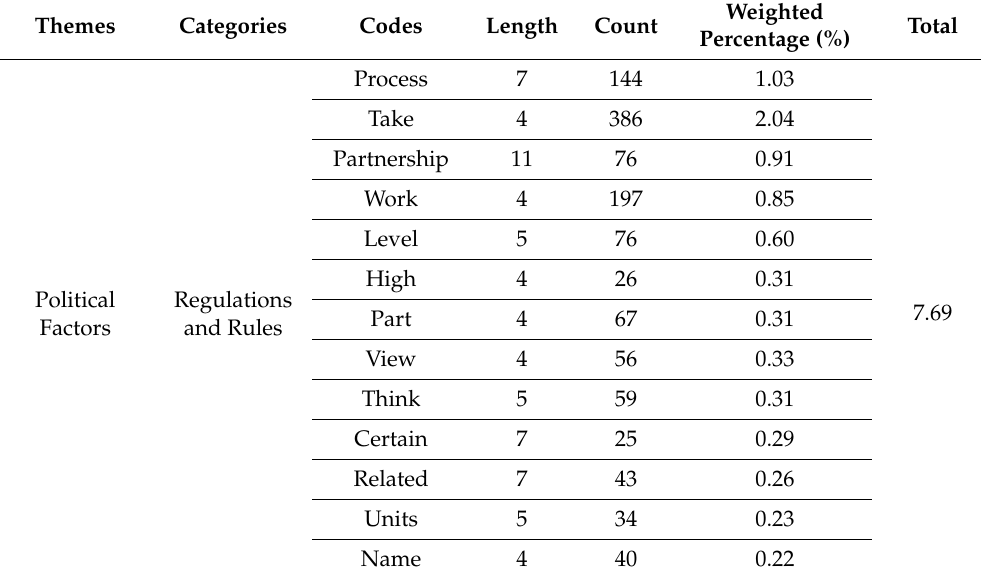
Table 7. Word frequencies for political factors